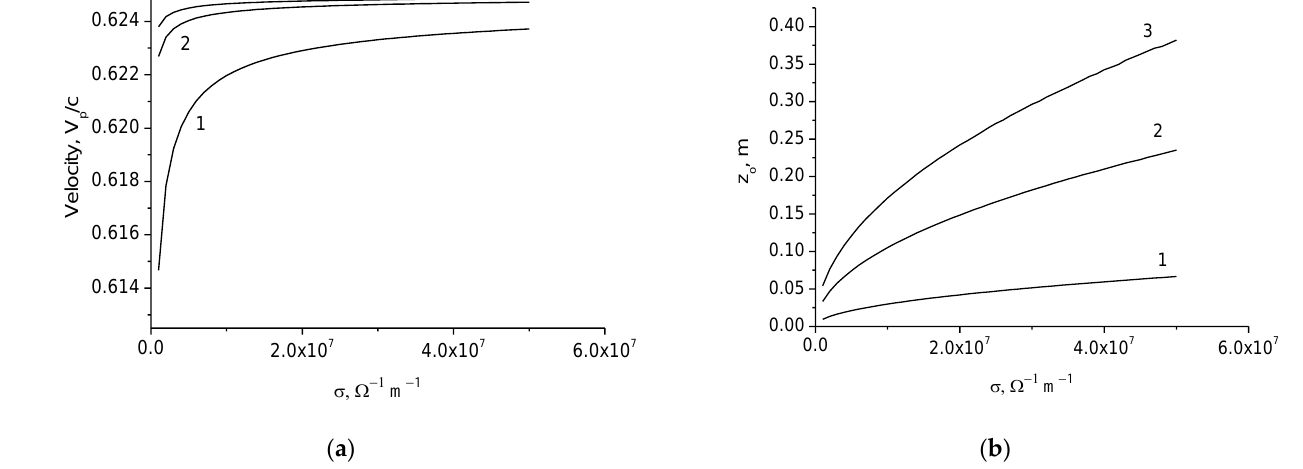
Figure 9. The velocities ( a ) and attenuation lengths ( b ) as a function of conductivity. 𝜔 = 1 THz; 1 − 𝑟 0 = 1 μm ; 2 − 𝑟 0 = 5 μm ; 3 − 𝑟 0 = 10 μm . 𝜀 𝑑′ = 2.56; 𝜀 𝑑′′ = 0 . It follows from simulations that for a given conductivity, the velocity and the atten- uation length are higher for a larger wire radius. Figure 10 shows the velocities and attenuation lengths depending on the conductiv- ity for different wire radii, taking into account the absorption in the dielectric coating. Here, the imaginary part of the dielectric permittivity of the coating is equal to 𝜀 𝑑′′ = 0.01 , which corresponds to the effective material loss 𝛼 = 0.1 cm −1 .